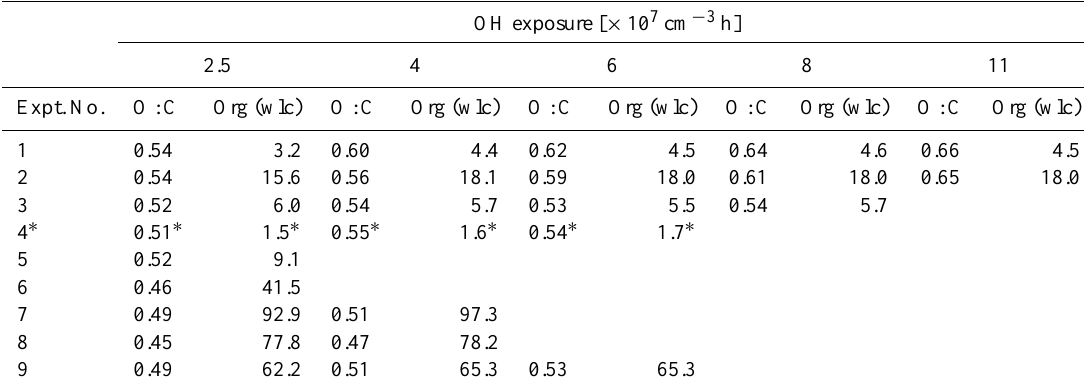
Table 2. Thirty-minute averages of O:C and wall-loss-corrected organic mass concentration inµgm − 3 , org (wlc) at the given OH exposures. The data are displayed in Fig. 3.